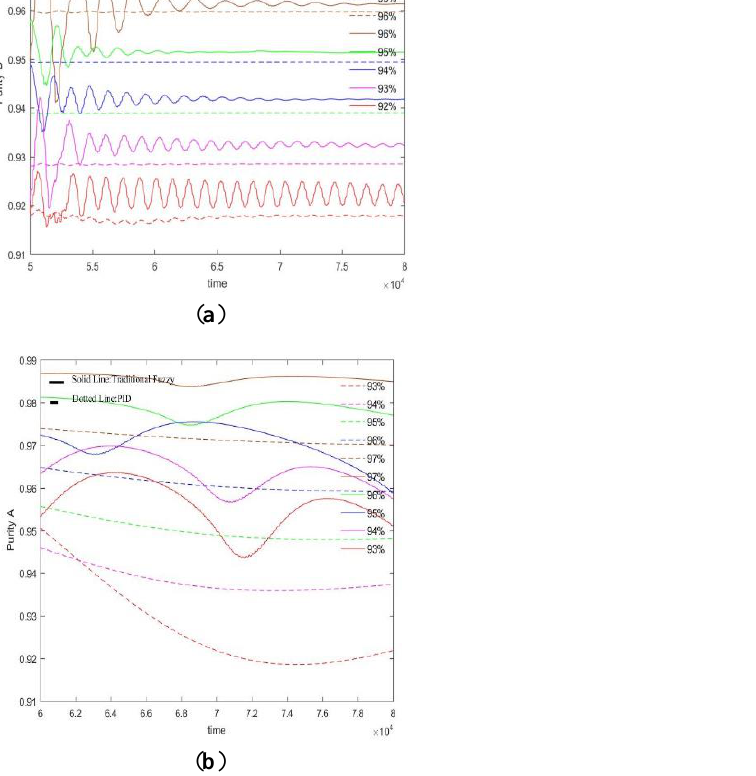
 Figure 19. Under the change of the switch time . ( a ) Extraction outlet (material Figure 19. Under the change of the switch time θ = 178 s → 182 s . ( a ) Extraction outlet (material B); B); ( b ) raffinate outlet (material A). ( b ) raffinate outlet (material